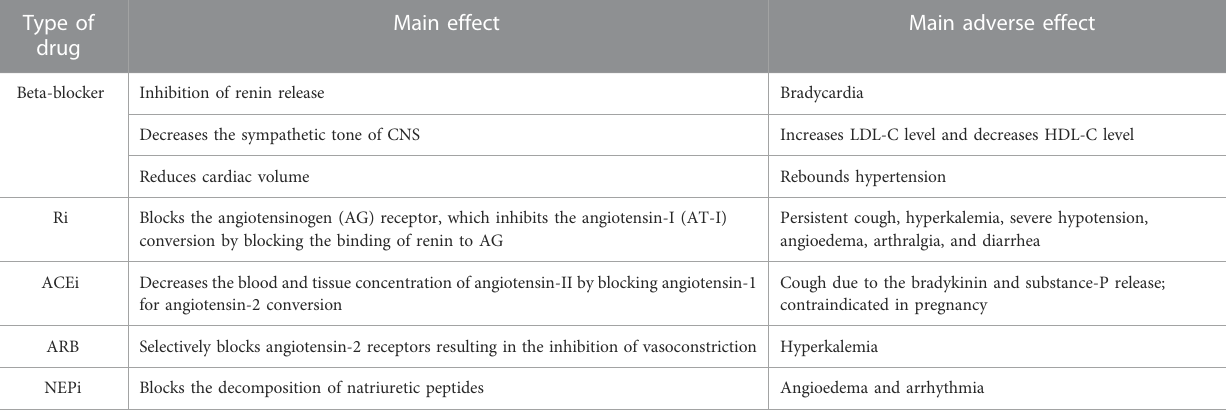
TABLE1Syntheticdrugsaffectingtherenin –